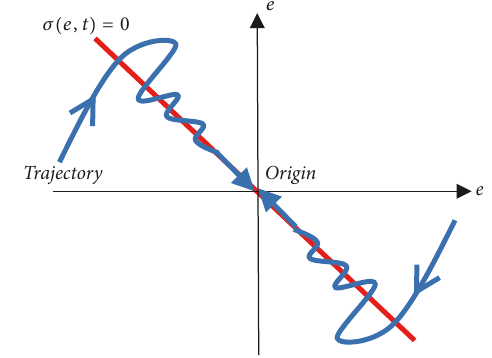
Figure 2: Attractive property of the sliding